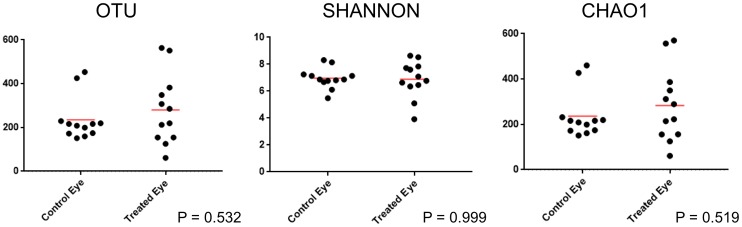
Scatter plots and statistical evaluation of 16S rRNA gene sequences obtained from 12 healthy horses (24 eyes), comparing treatment and control eyes at baseline (day 0).Each dot represents one eye. There is no difference in alpha diversity between eyes at baseline (Wilcoxon match-pairs signed-ranks test).